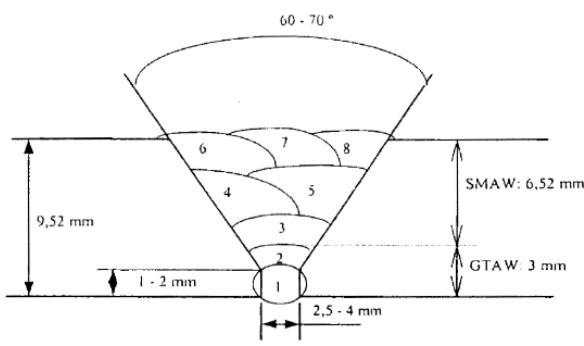
Figure 1. Welding Figure 1. Welding configuration.